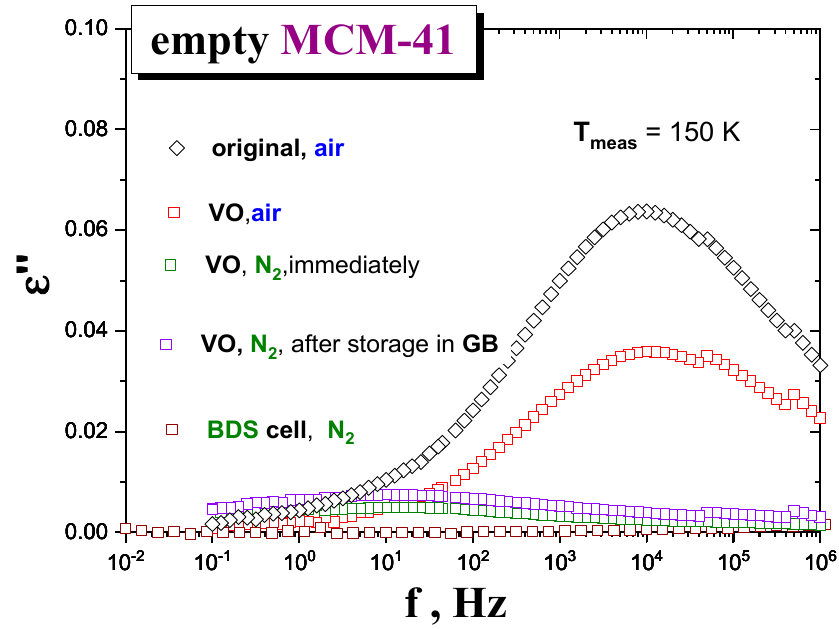
Figure 2. Comparison of the BDS spectra recorded at 150 K of the empty MCM-41 in the original (untreated) state (black diamonds) and in a series of thermally treated empty MCM-41 samples by drying and subsequent manipulation, i.e., loading into the capacitor by various ways: ( a ) dried in the VO at 120 ◦ C for six days and subsequently filled into the capacitor under the air ( N 2 + O 2 + moisture ) atmosphere (red squares); ( b ) dried in the VO at 120 ◦ C for one day and subsequently filled into the capacitor under N 2 in the GB and measured (i) immediately (green squares) and (ii) after five days’ storage in the GB (blue squares) and finally; ( c ) dried at 120 ◦ C for 2 h, directly in the BDS cell, under N 2 (brown squares). All the empty MCM-41 samples were undergone by the same cooling treatment with − 2 K/min from RT down to 100 K and subsequently measured isothermally with Δ T = 5 K from 100 up to 300 K.